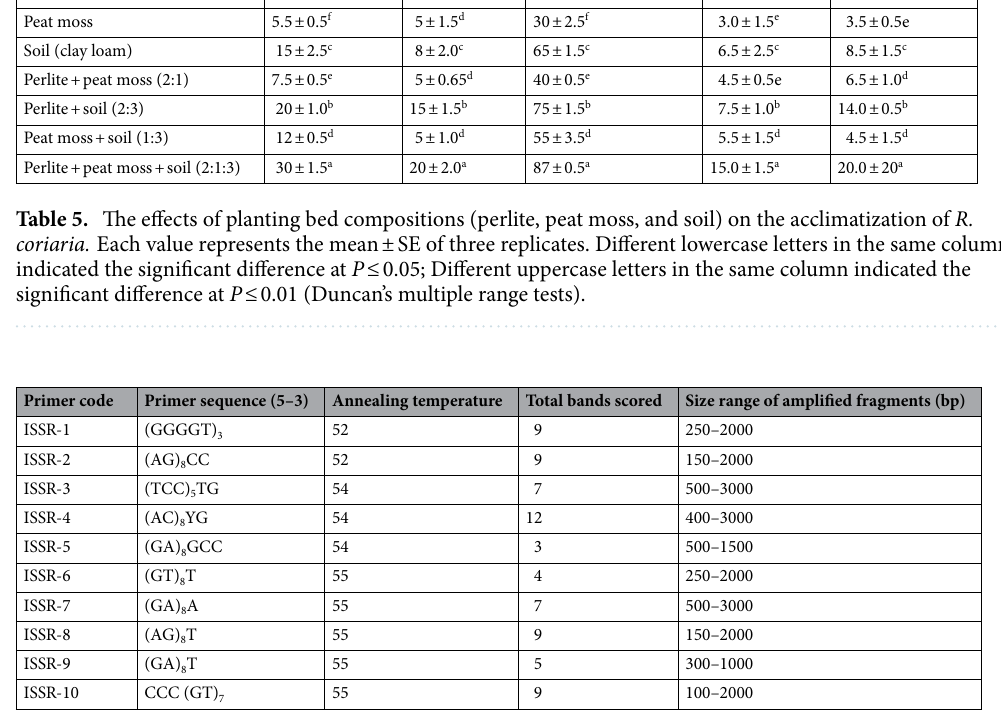
Table 6. Details of ISSR primers and total number of bands and size range of amplified fragments generated by ISSR makers in R. coriaria.